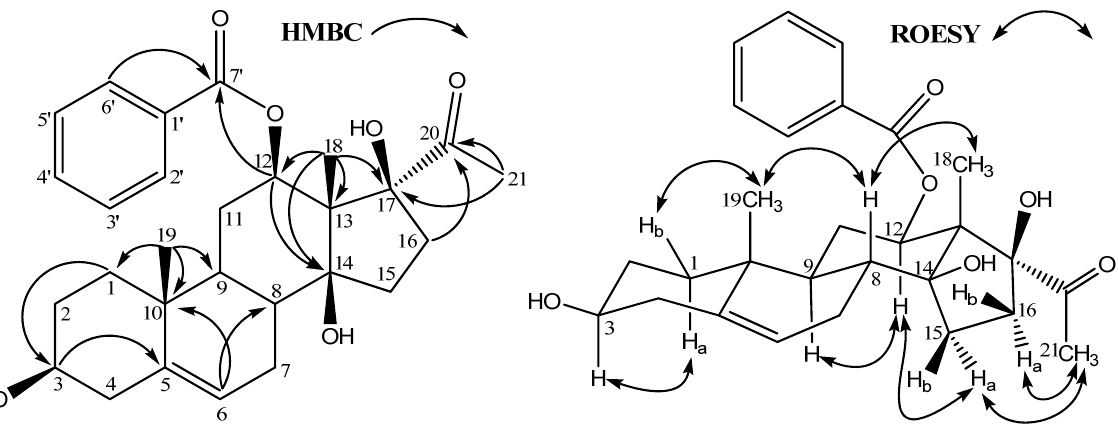
Figure 2. Key HMBC and ROESY correlations of compound 1.